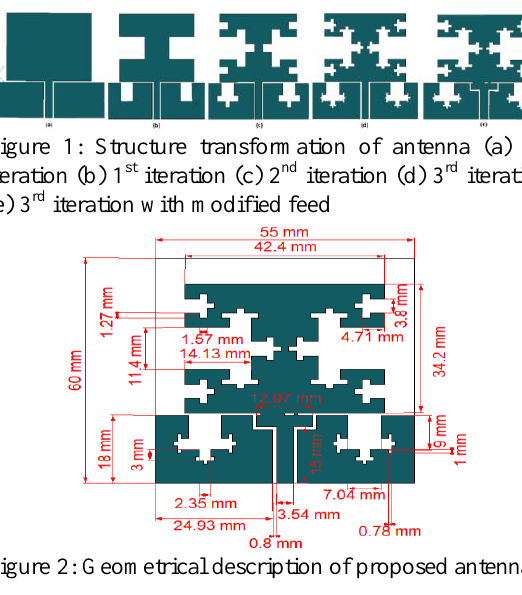
Figure 2: Geometrical description of proposed antenna loaded rectangular radiator fed by a modified